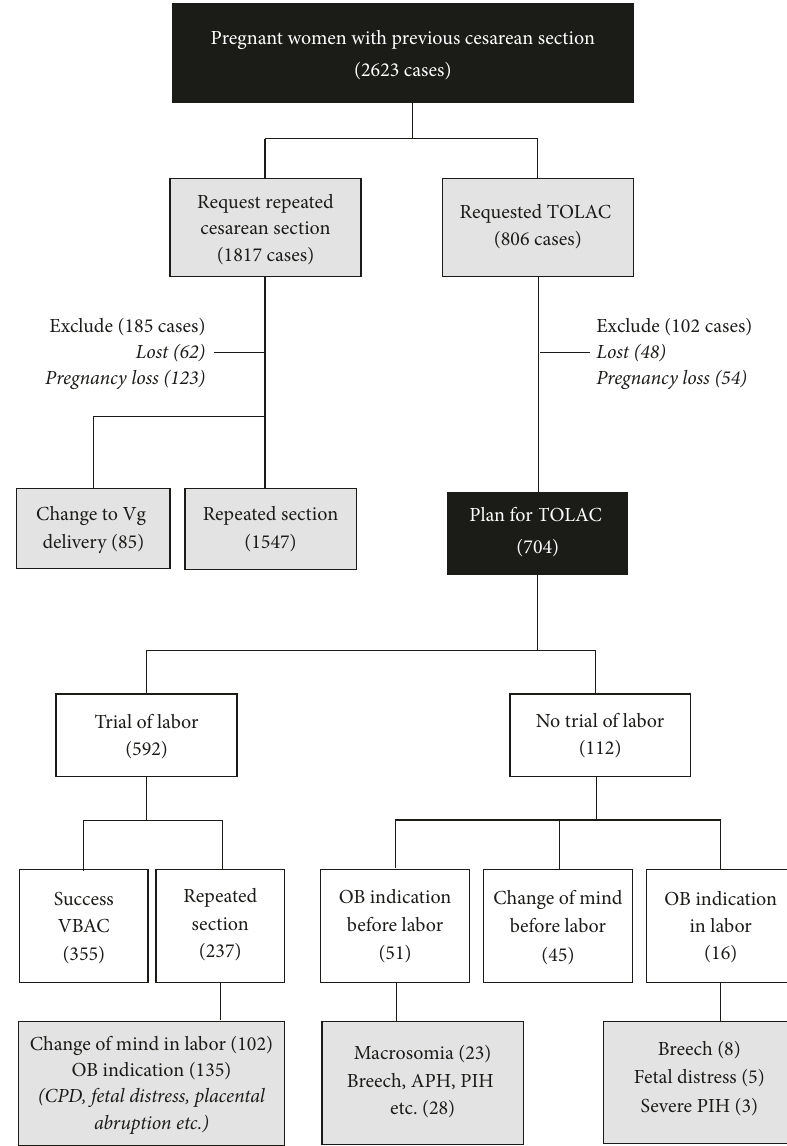
Figure 1: Pregnancy outcomes in both